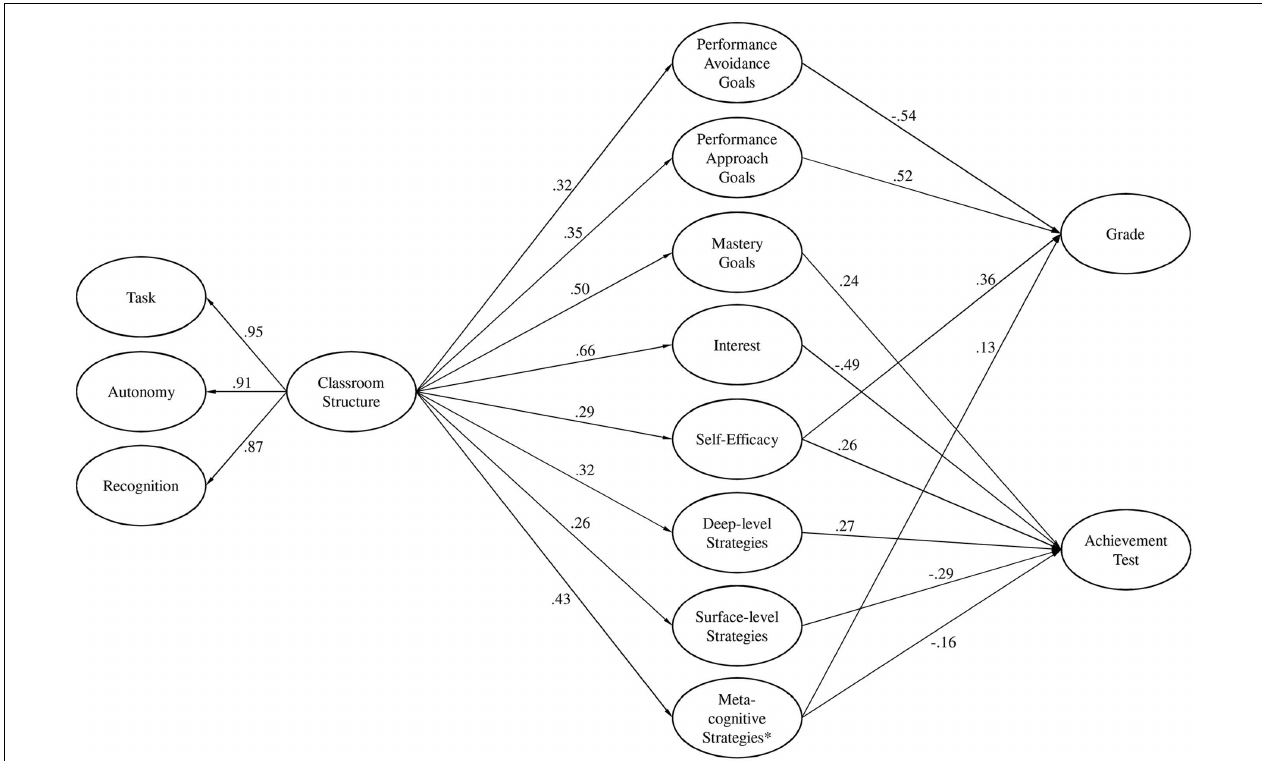
FIGURE 1 | Results concerning the structural model (classroom structure – lifelong learning determinants – achievement). Standardized regression coefficient are reported and non-significant paths are not shown. Analyses were performed with Mplus 7.31; Achievement test percentile rank values were z-standardized using the error function prior to analyses. All other items were treated as ordered categorical, utilizing the WLSMV estimator. ∗ Due to problems with multicollinearity meta-cognitive learning strategies were estimated in a separate